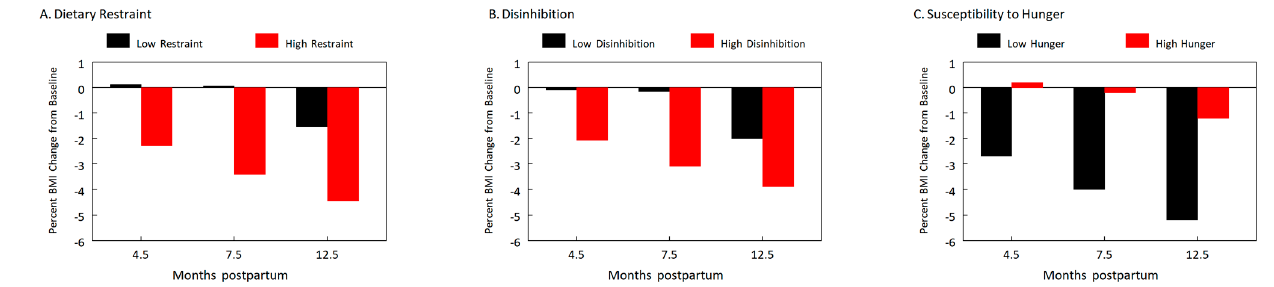
Figure 3. Psychological constructs of dietary restraint ( A ), disinhibition ( B ), and susceptibility to hunger ( C ) measured at baseline (0.5 month postpartum) interacted with time and were inde- pendently associated with BMI changes postpartum ( n = 201). Each psychological construct is cate- gorized by median split (dietary restraint: low < 5, high ≥ 5; disinhibition: low < 4, high ≥ 4; suscep- tibility to hunger: low < 3, high ≥ 3) and plotted as percent BMI change at 4.5 months, 7.5 months, and 1 y.